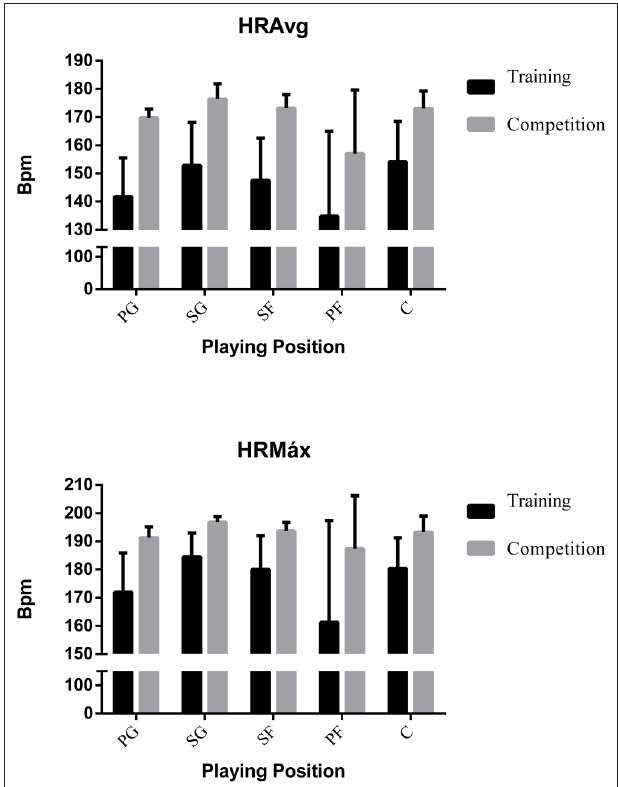
FIGURE 5 | Internal load by playing